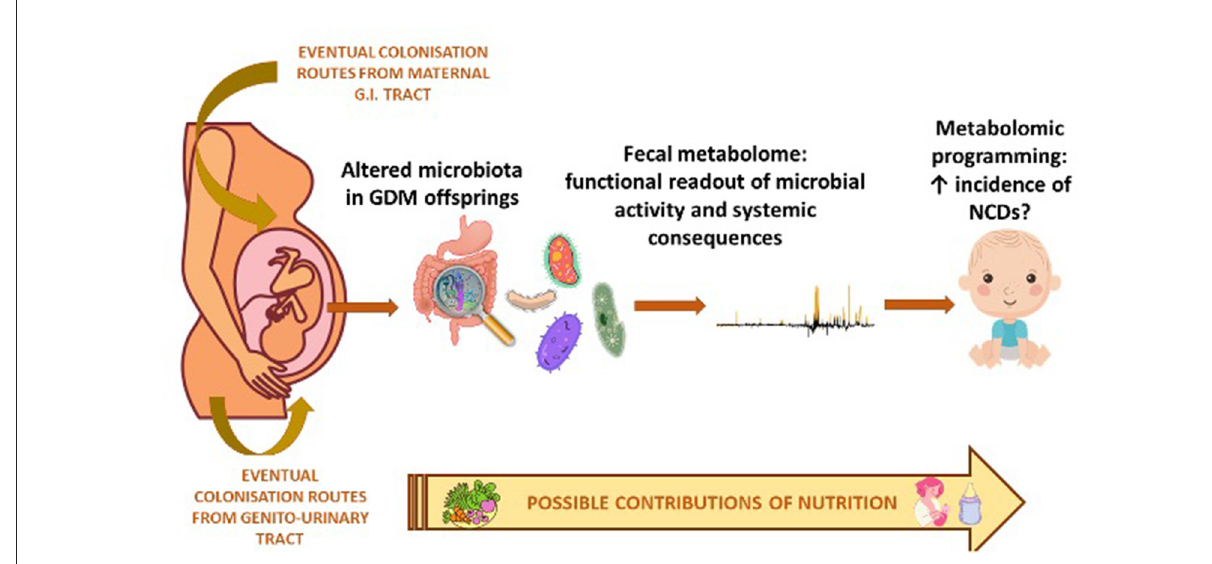
FIGURE1 Synergy of action of metabolomic and microbiomic investigation in the offspring of diabetic